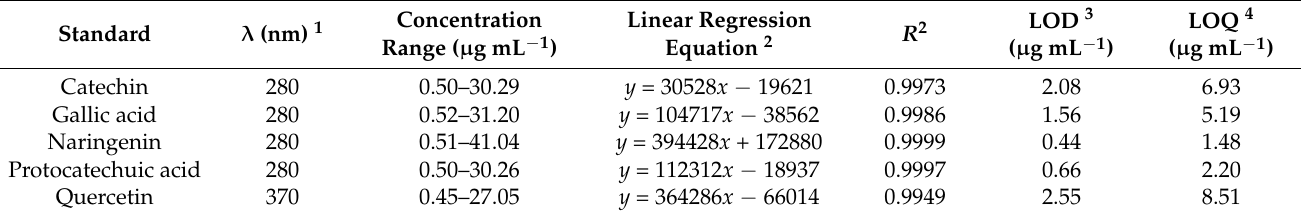
Table 1. UHPLC-UV standard data used for the quantitative analysis of the identified compounds in Pinus spp. bark polar